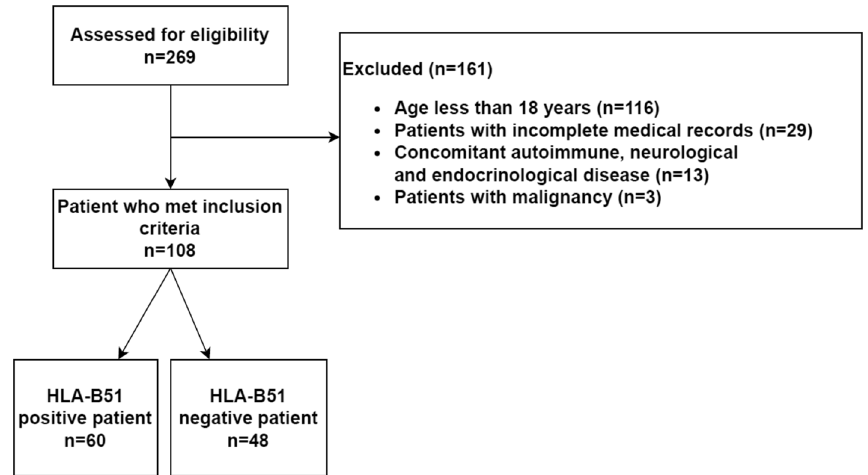
Fig. 1 The participant recruitment scheme